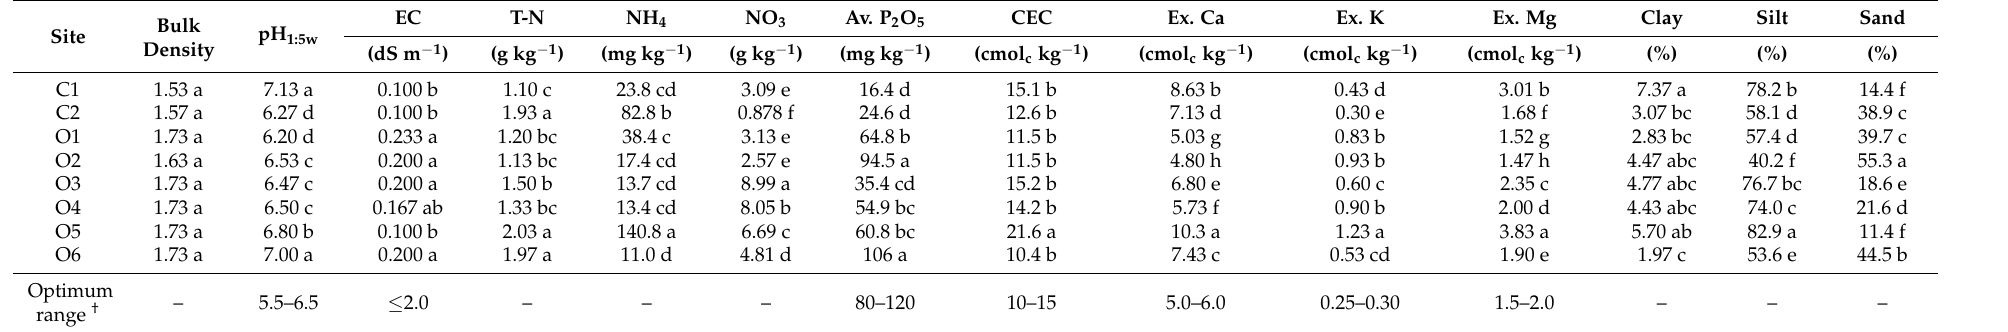
Table 3. Physicochemical properties of paddy soils treated with different fertilization